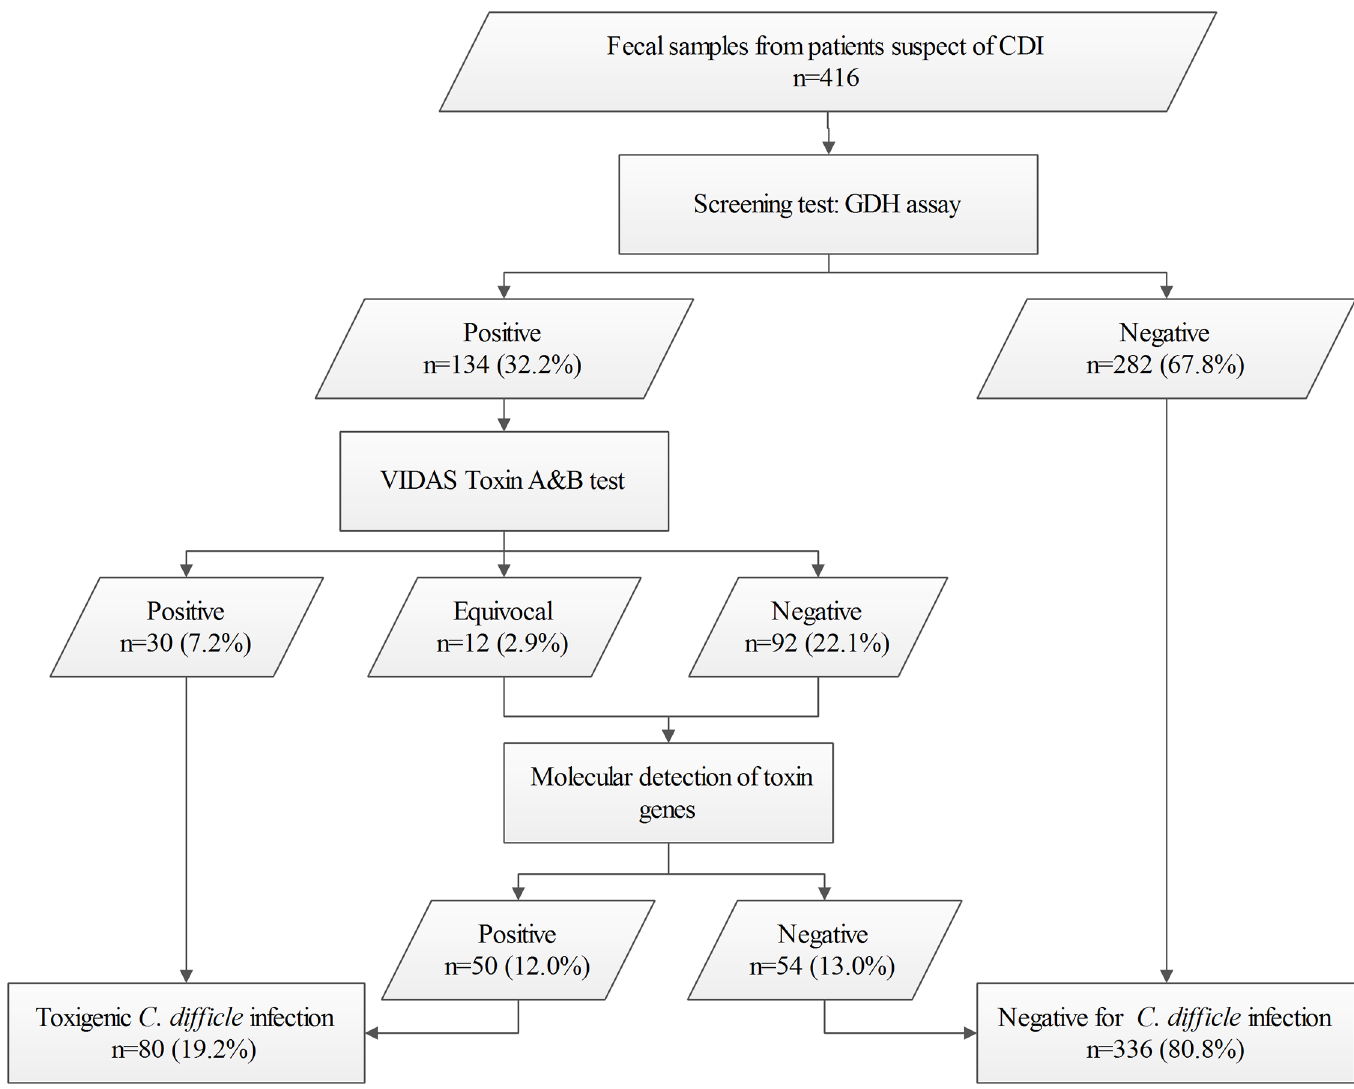
Fig 1. A proposed GDH-based workflow for laboratory diagnosis of C . difficile infections (CDI). Abbreviations in the figure: GDH, glutamate dehydrogenase. Cell cytotoxicity neutralization assay or toxigenic culture could be used as alternative testing methods for determining toxigenicity of C . difficile where molecular methods were not